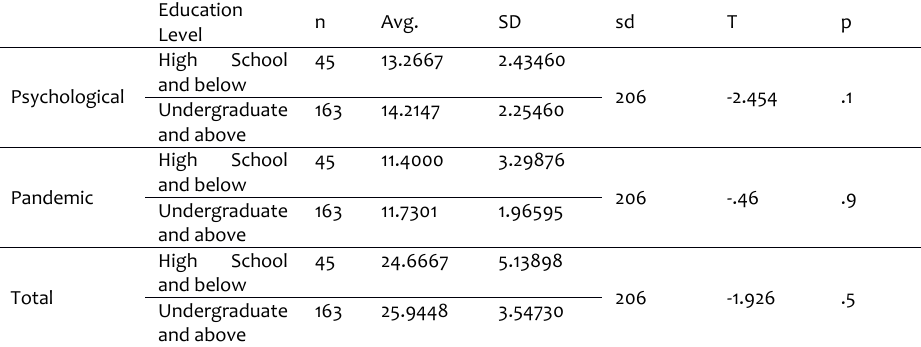
Table 3. The mean scores and t-test results of the reactions of the children to the pandemic according to the education levels of the parents (n=208) Education Avg. Level